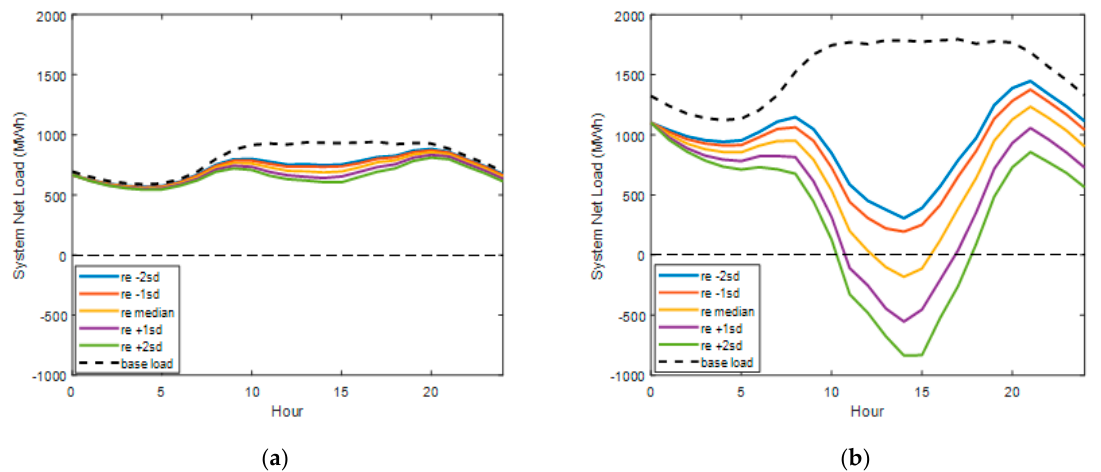
Figure 3. Forecasted net load for peak days in Jeju Island in 2019 and 2030: ( a ) 2019; ( b ) 2030.